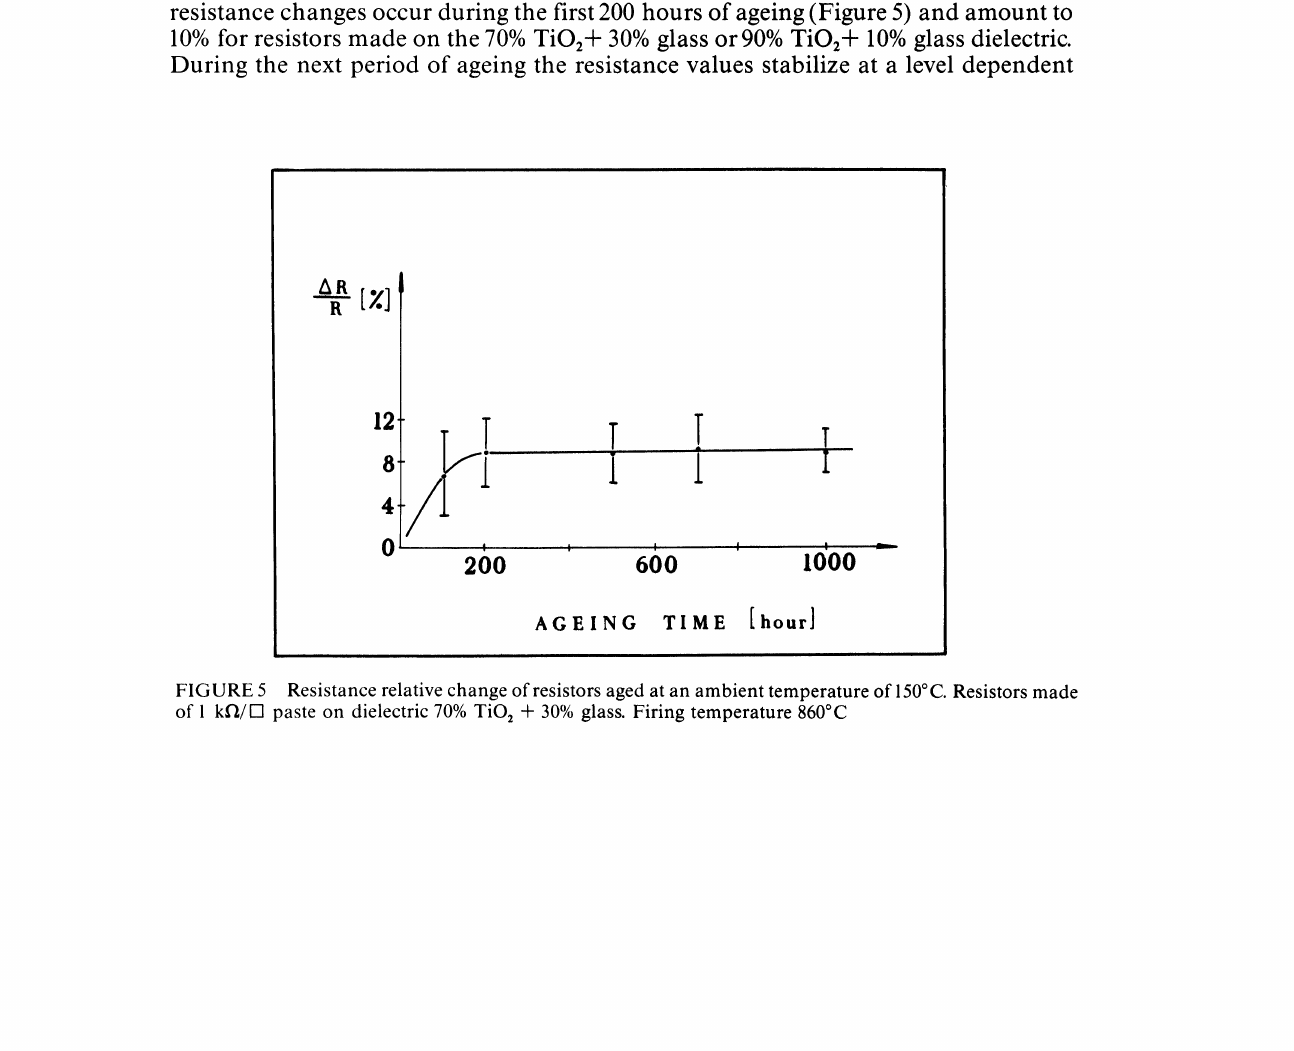
FIGURE 5 Resistance relative change of resistors aged at an ambient temperature of 150C. Resistors made of kfl/[ paste on dielectric 70% TiO / 30% glass. Firing temperature